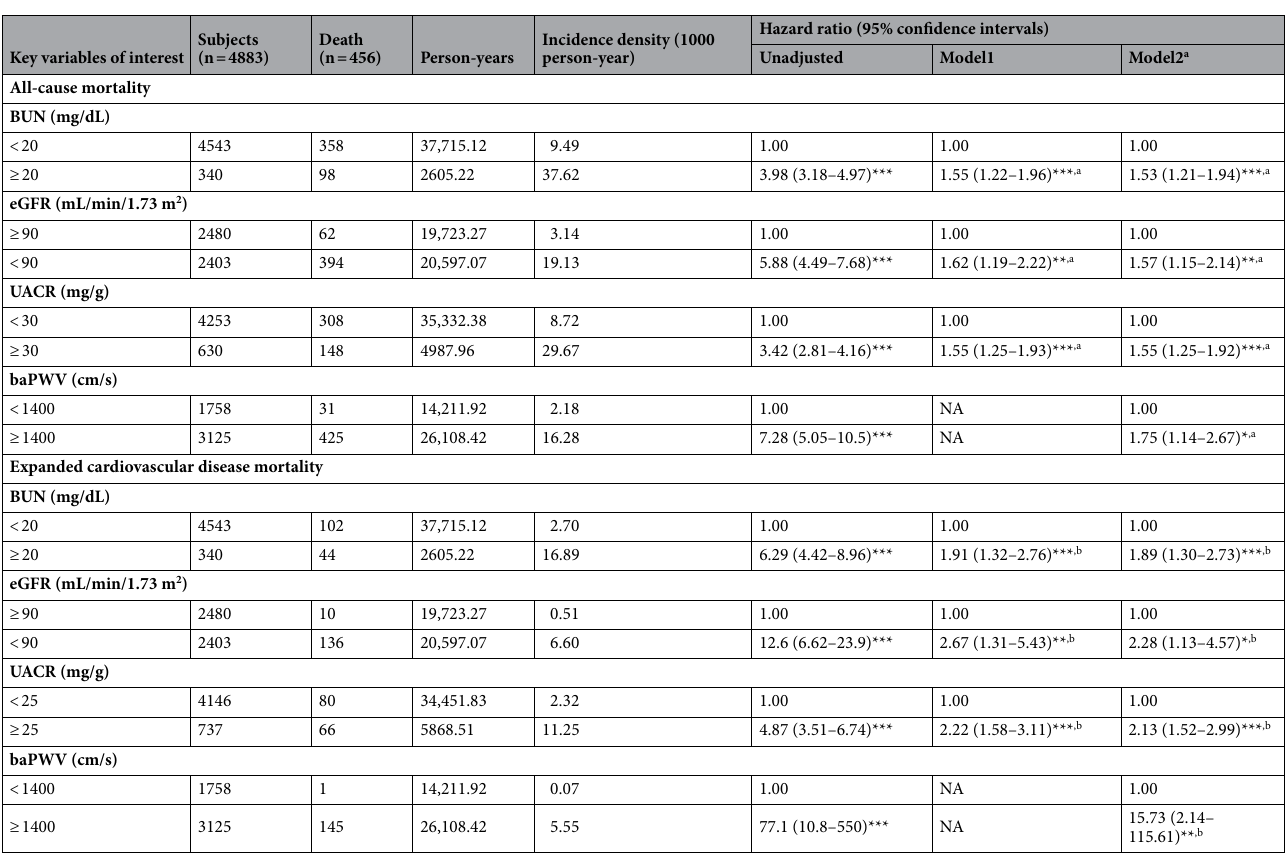
Table 2. Hazard ratios of renal-related variables for all-cause and expanded cardiovascular disease mortality from Cox proportional hazard models. NA Not applicable, M man, W women, SBP systolic blood